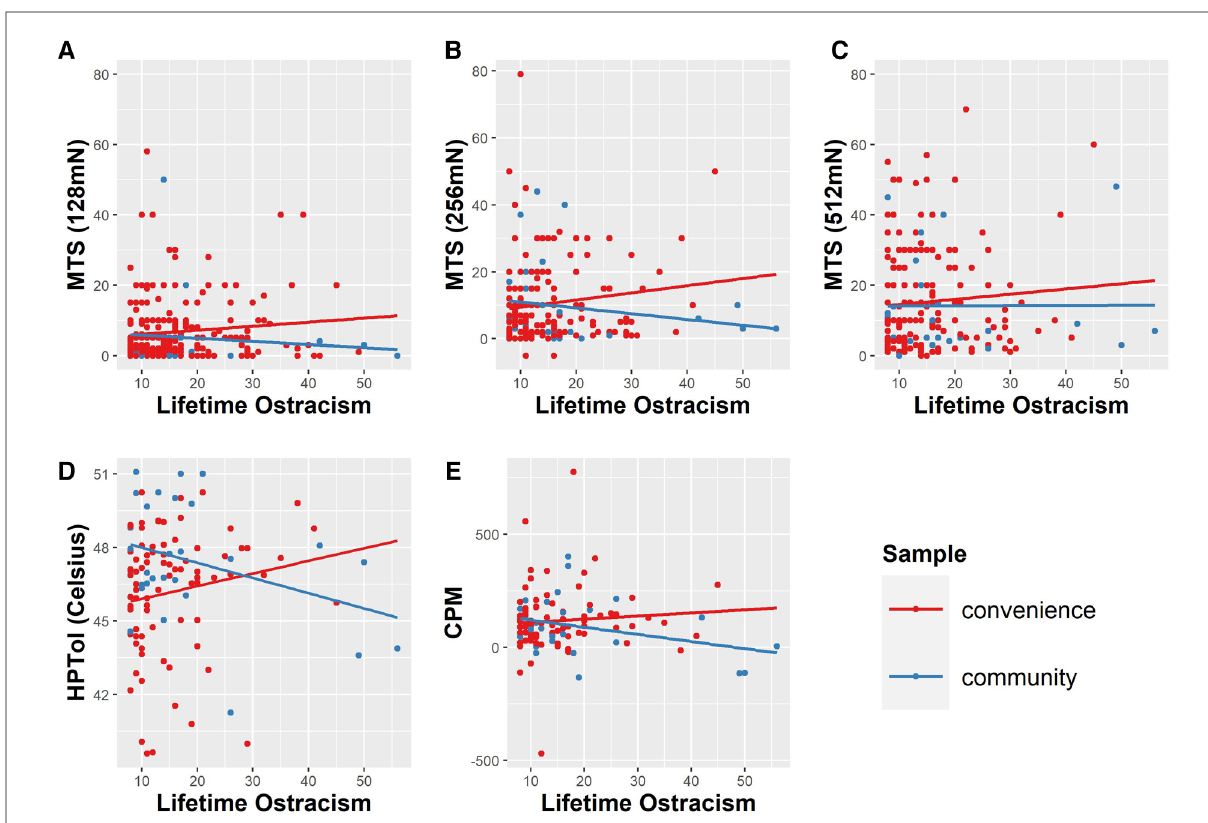
FIGURE 2 Sample population signi fi cantly ( p <0.05) moderated the relationship between lifetime ostracism experiences and ( D ) heat pain tolerance (HPTol °C ) and ( B ) mechanical temporal summation (MTS) using the 256 mN weighted probe. A similar, yet non-signi fi cant pattern was observed for the relationship between lifetime ostracism and ( A & C ) MTS using other weighted probes as well as ( E ) conditioned pain modulation (CPM). The raw, untransformed values are presented in the fi